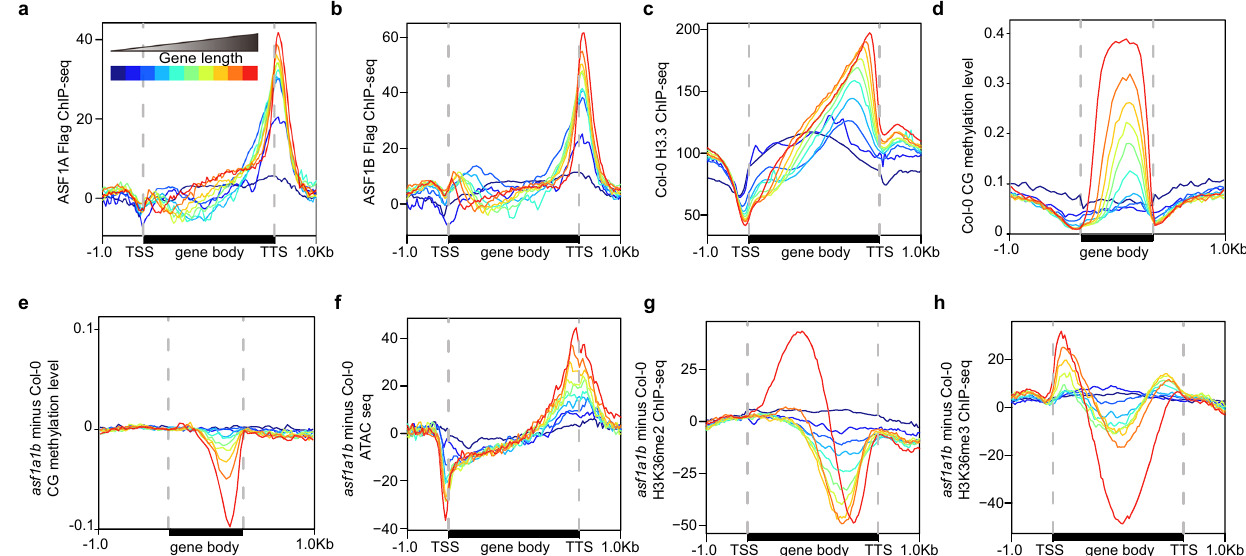
Fig. 6 | Effects of asf1a1b on the distribution of epigenetic marks ranked by gene length. a Metaplot showing ASF1A ChIP-seq signal over genes grouped by gene length. b Metaplot showing ASF1B ChIP-seq signal over genes grouped by gene length. c Metaplot showing H3.3 ChIP-seq signal in Col-0 overgenesgrouped by gene length. d Metaplot showing CG methylation levels in Col-0 CG over genes grouped by gene length. e Metaplot showing CG methylation level difference in